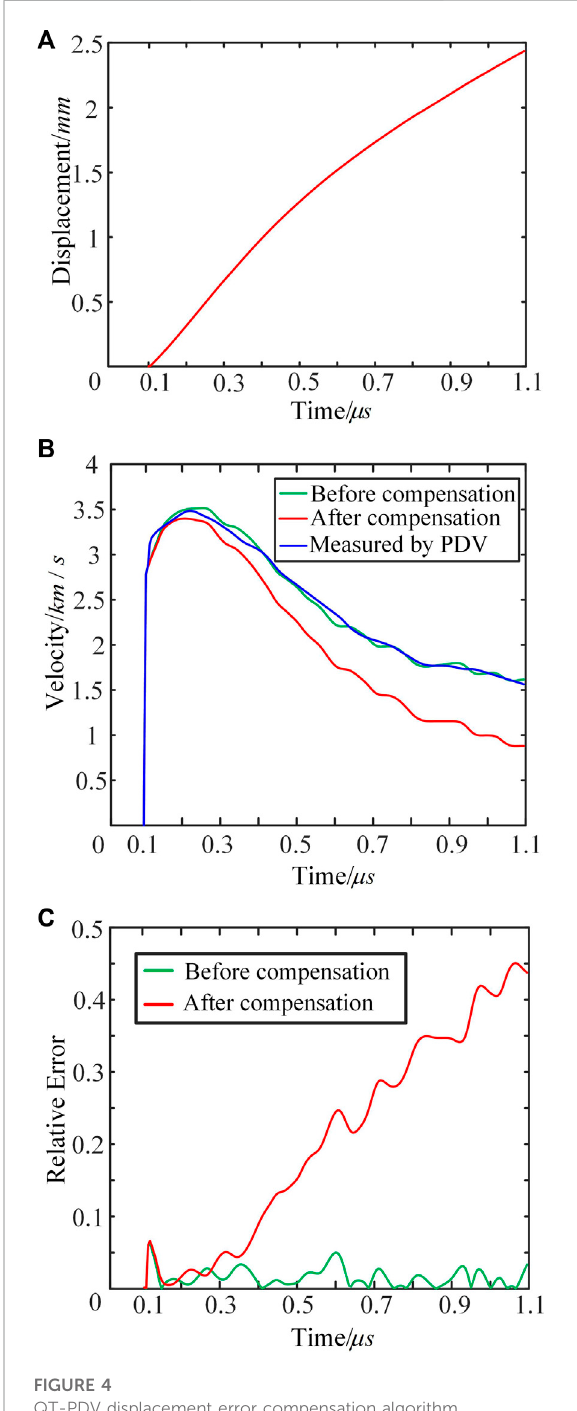
FIGURE 4 QT-PDV displacement error compensation algorithm processing results. The velocity and displacement are separated from the frequency domain by Eq. 9 to compensate the measurement results. (A) Is the displacement signal separated in the frequency domain, (B) is the comparison graph of the velocity signal before and after compensation of the QT-PDV measurement results, the red line indicates the velocity signal before compensation, the green line indicates the velocity signal after compensation, and the blue line indicates the